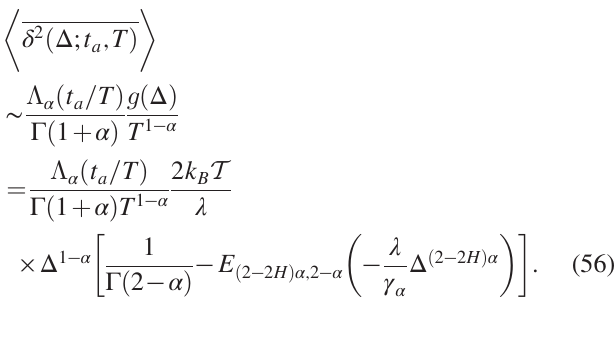
Figure 6 gives several examples for the detailed turnover behavior of the mean-squared displacement for various values of α and H . At infinite times t → ∞ , the ensemble mean-squared displacement converges to the Boltzmann limit. At finite times, we generally observe subdiffusive behavior. The dynamics are slowest when t is short as compared to both intrinsic relaxation and aging time scales. Notice that the behavior at times t ≫ τ (cid:2) α is independent of